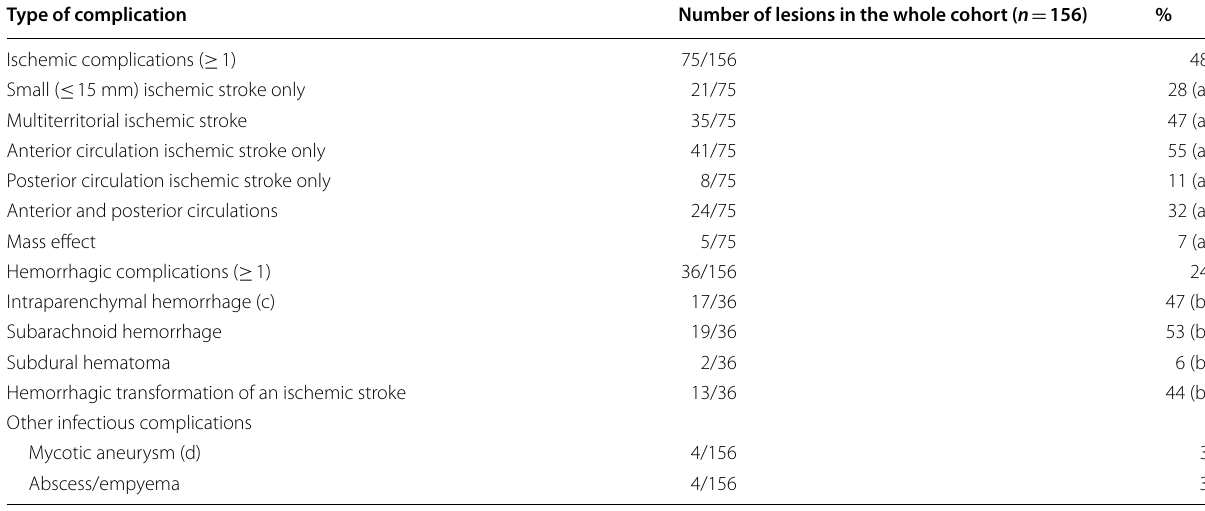
Table 2 Details of CT‑defined neurological complications identified on baseline brain